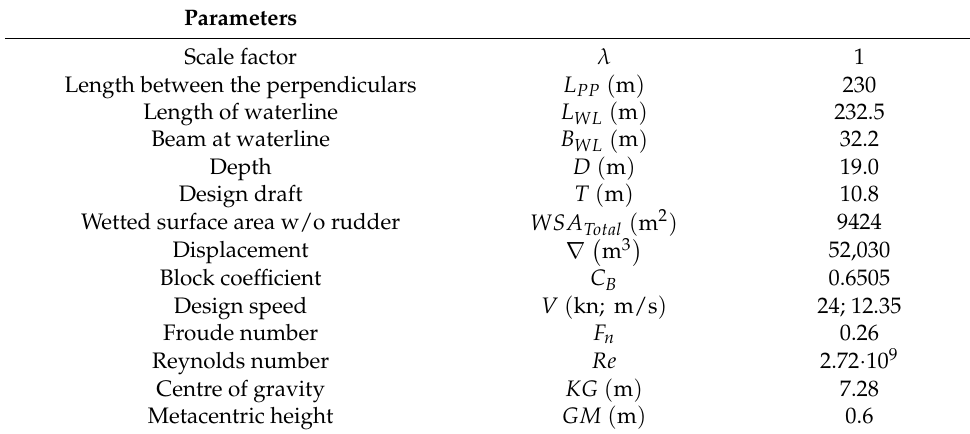
Table 7. KRISO Container Ship (KCS) full-scale principal